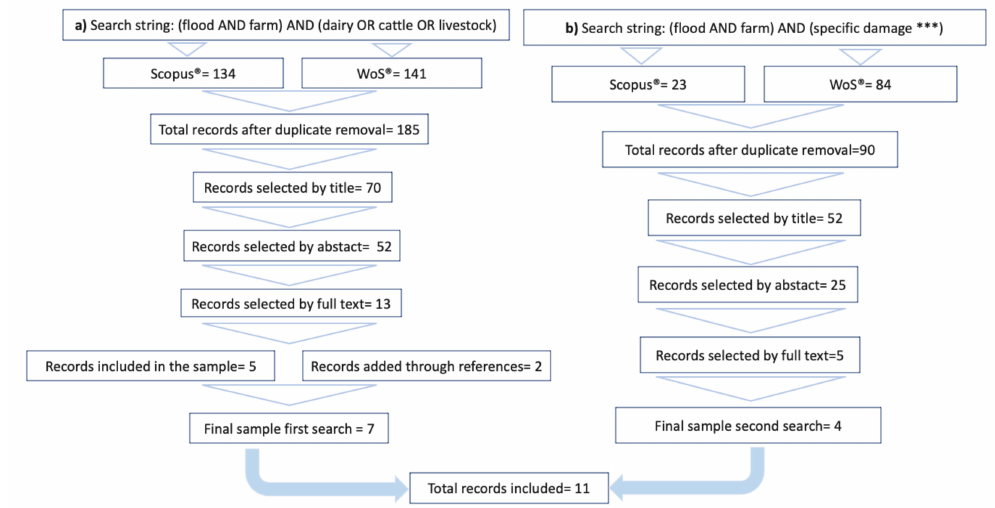
Figure 3. ( a , b ) Selection of literature from Scopus and Web of Science: first search identified the type of damage ( a ) on the left, and ( b ) the second search quantified the specific damage types on the right. *** specific damage types: “flood” and “cattle” or “dairy” and “lameness”; “Clostridium” or “ Fasciola hepatica ” or “anthrax” or “leptospirosis”; “reproduction” or “abortion” or “conception rate”; “feed supply” or “water